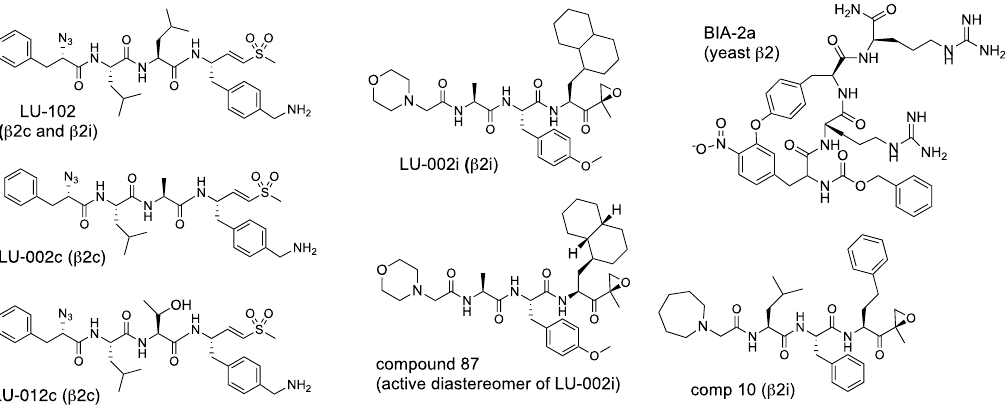
Figure 9. β 2 inhibitors. Figure 9. β2 inhibitors.